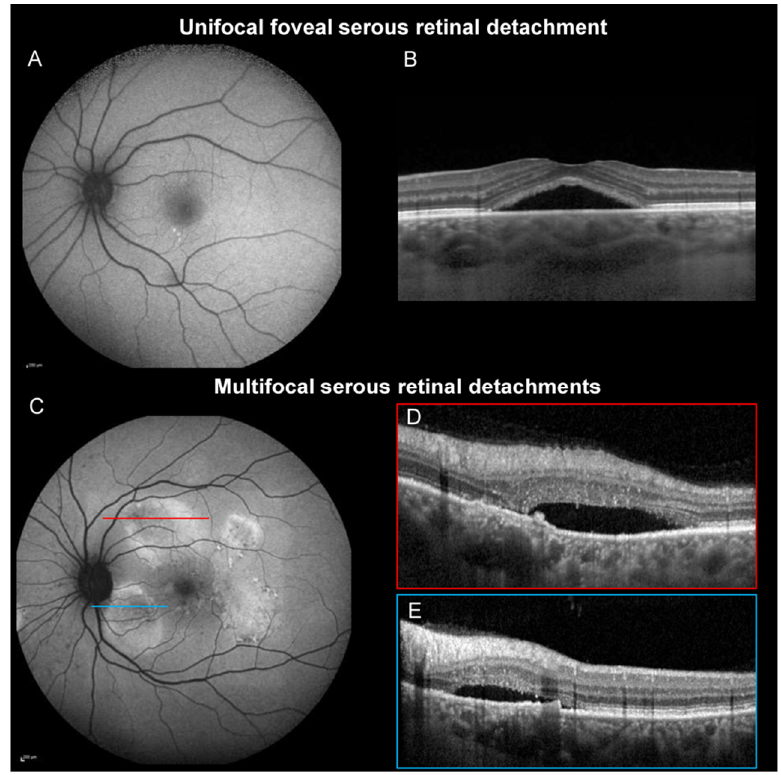
Figure 1. ( A , B ) Central serous chorioretinopathy (CSCR) with a unifocal macular serous retinal de ‐ tachment (SRD). ( A ) Blue ‐ light fundus autofluorescence (BAF) shows no signs of previous extra ‐ macular SRD. ( B ) The OCT B ‐ scan shows a macular SRD. ( C , E ) CSCR with multifocal SRD.( C ) BAF shows a mixed multifocal round area of hyper/hypo ‐ autofluorescence consistent with an active or resolved SRD. ( D , E ) The OCT B ‐ scan passing through the round hyper ‐ autofluorescent area